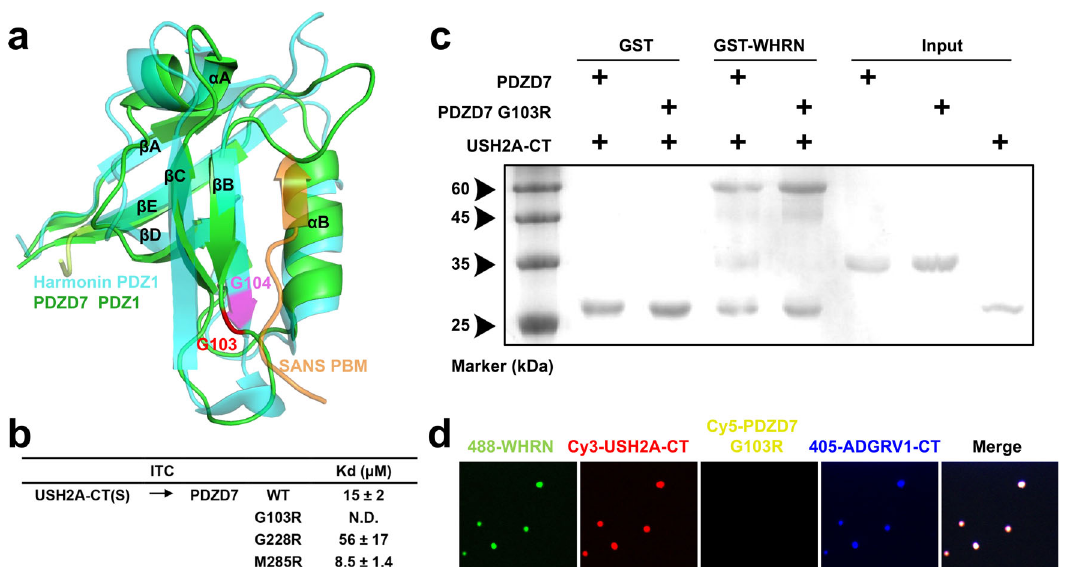
Fig. 10 | Deafness-related mutation on PDZD7 affects the LLPS capacities of USH2 proteins. a PDZD7 PDZ1 is structurally superimposed with Harmonin PDZ1/ SANS PBM 29 . Superimposition shows that G103 on PDZD7 PDZ1 corresponds to G104onHarmoninPDZ1.G103localizesonthebindinggrooveandmaybeinvolved intheinteractionwithUSH2A. b Summariesofthebindingaf fi nitiesbetweenWTor deafness-related mutants of PDZD7 and USH2A-CT(S). N.D., not detectable. c GST